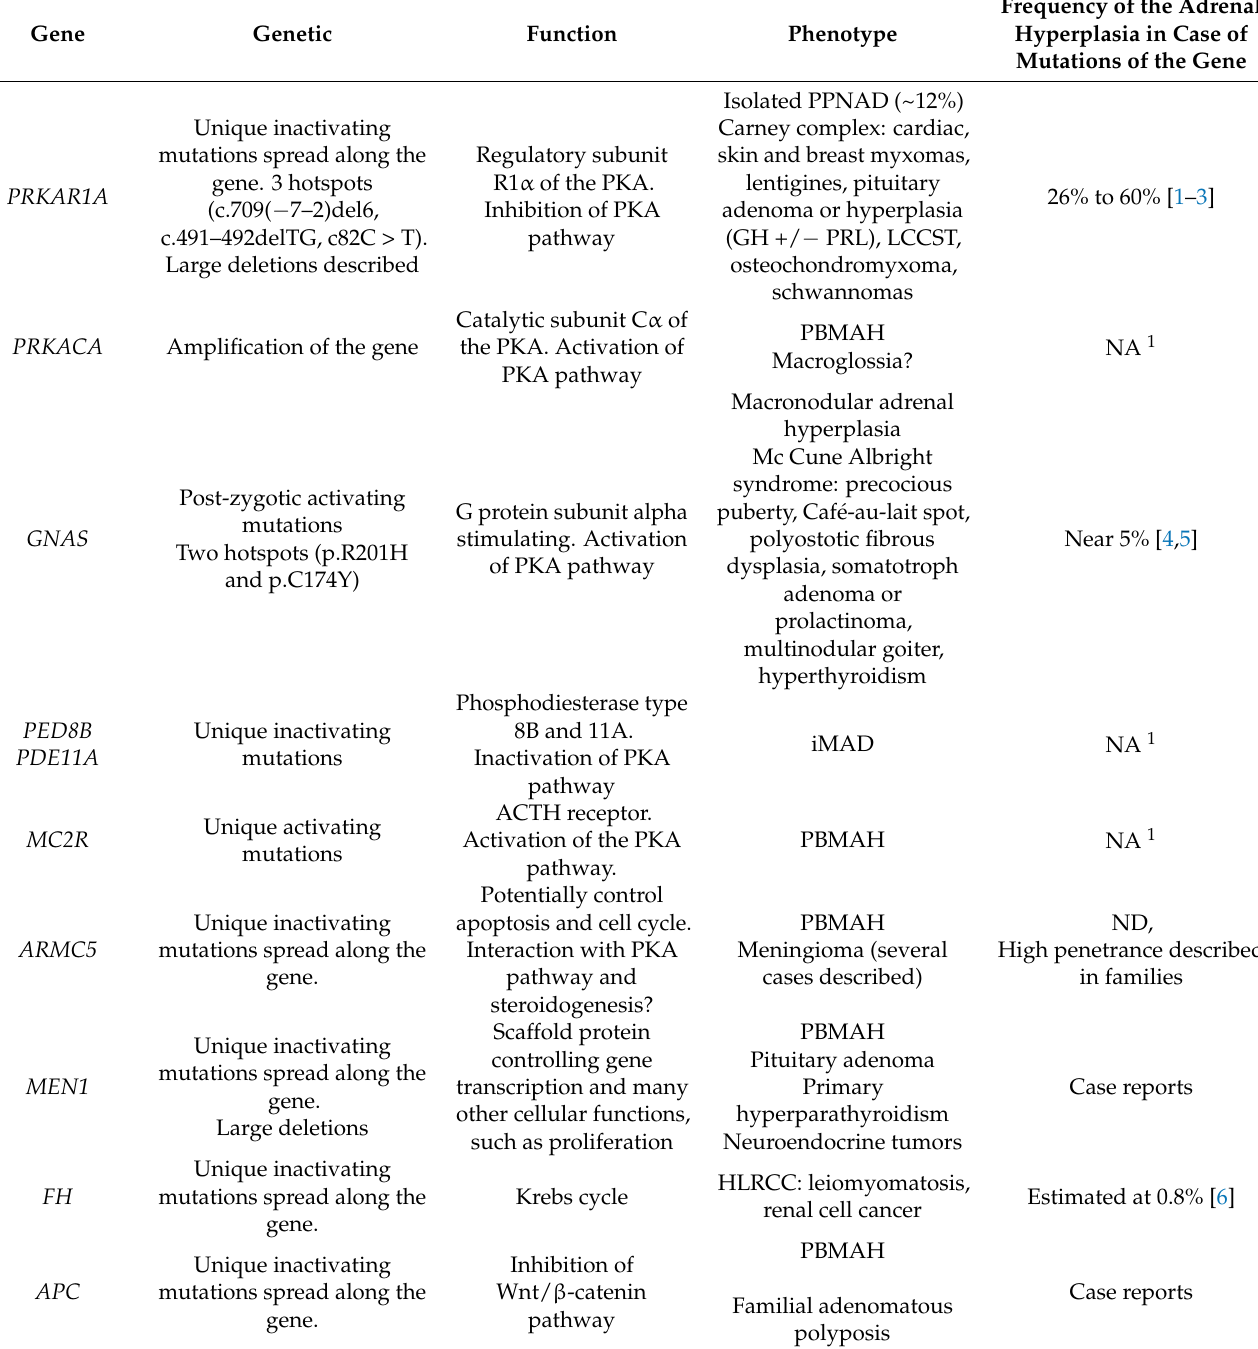
Table 1. Germline defect associated with adrenal hyperplasia. 1 NA: Not Applicable: the described mutations may lead only to adrenal hyperplasia, but they have been described only in case